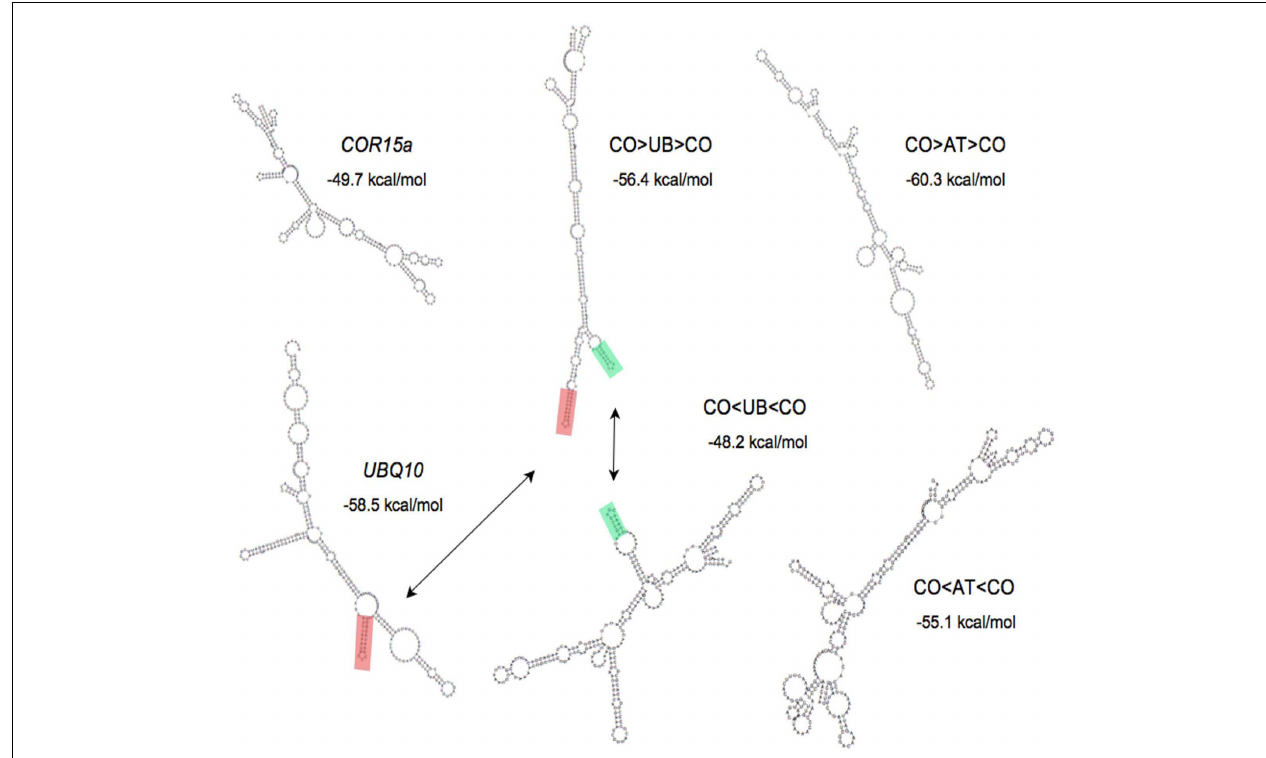
FIGURE 4 | Predicted secondary structure of introns. The minimum free energy structure of introns as determined by theVienna package is shown. Stem loop structures conserved between introns are highlighted in red and